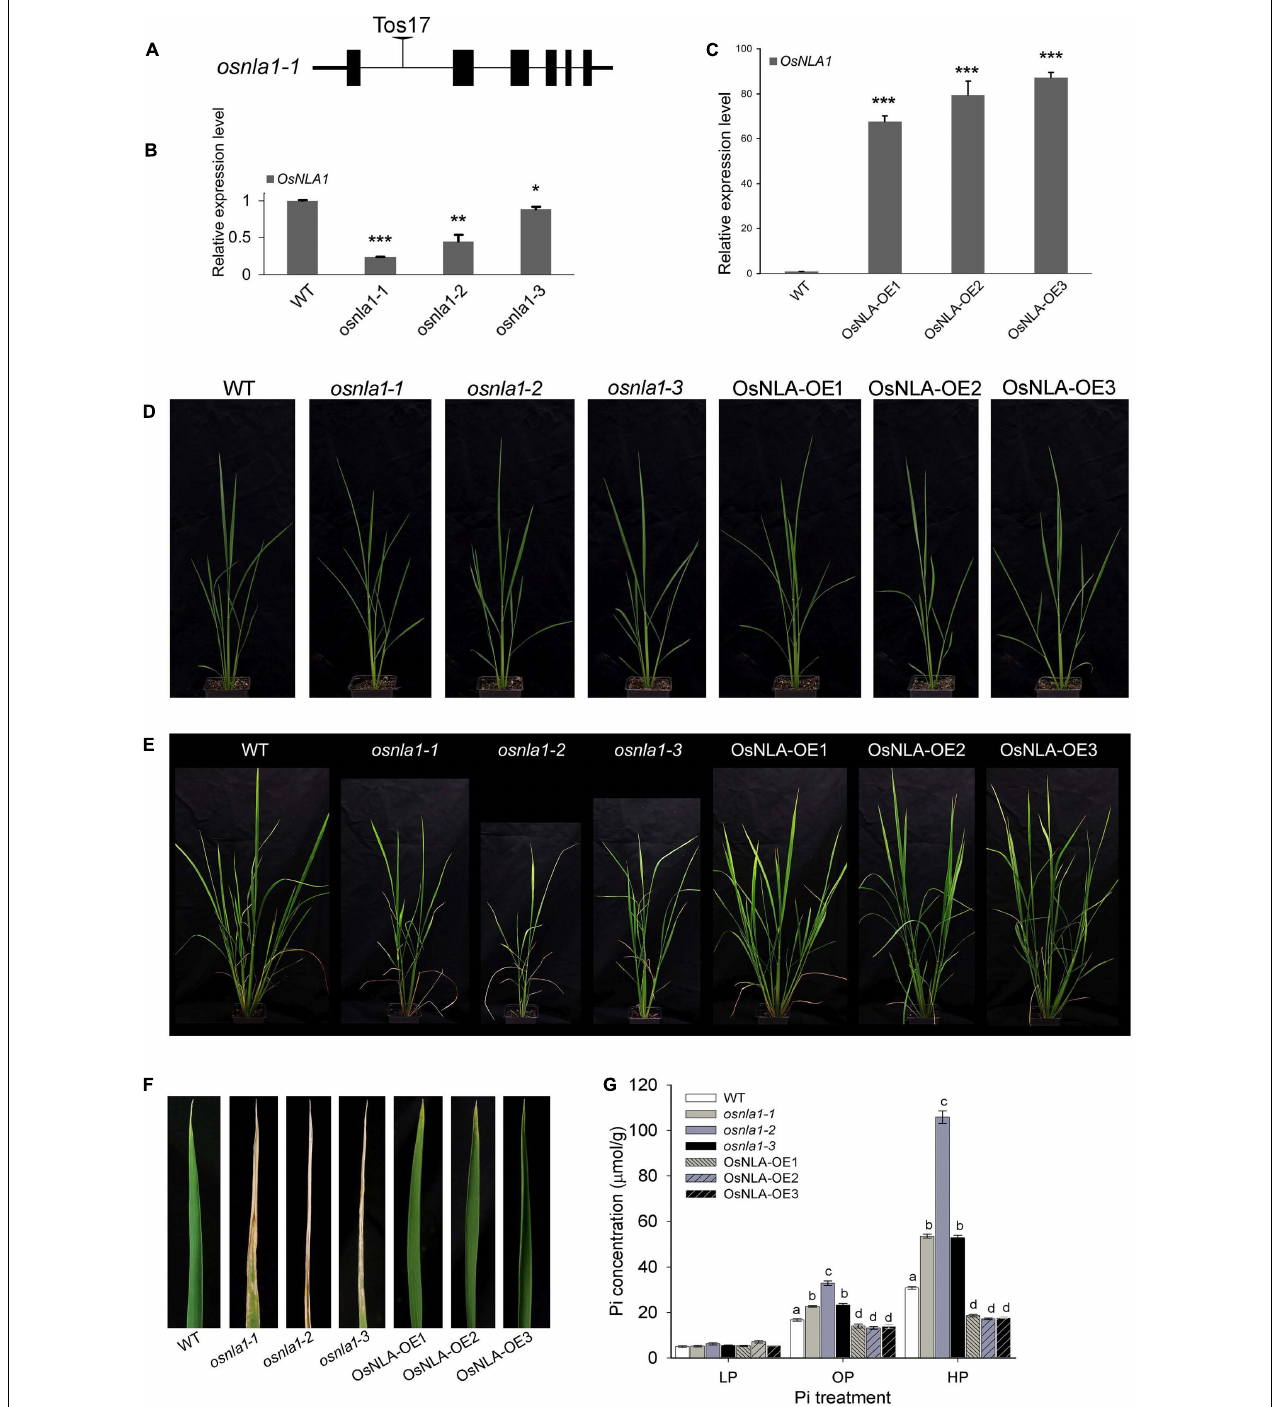
FIGURE 3 | Analysis of phenotype of OsNLA1 transgenic lines under different Pi levels. (A) Selected homozygous Tos17 insertion line (NG3578) with T-DNA insertion in the first intron ( osnla1-1 ), (B) the relative expression of OsNLA1 gene in T-DNA line ( osnla1-1 ) and two independent RNAi lines ( osnla1-2 and osnla1-3 ), and (C) the relative expression of OsNLA1in three over-expression lines (OsNLA-OE1, OsNLA-OE2, and OsNLA-OE3). The comparison was made relative to the wild-type, and determined by qRT-PCR analysis. Phenotypic analysis of plants grown in different Pi levels for 4–5 weeks after sowing seeds: (D) low and (E) high. With high Pi, knockdown lines showed (E) shorter plants with reduced tiller numbers and (F) severe leaf necrosis. (G) Pi content of leaf tissues, harvested from plants grown with low Pi (LP), optimum Pi (OP), and high Pi (HP) levels. Significance levels of P < 0.05 or P < 0.01 or P < 0.001 are denoted by ∗ or ∗∗ or ∗∗∗ , respectively. Different letters indicate significant differences at P ≤ 0.05 level (ANOVA, LSD test). Data are means ± SD of three to five replicates ( n = 3–5).